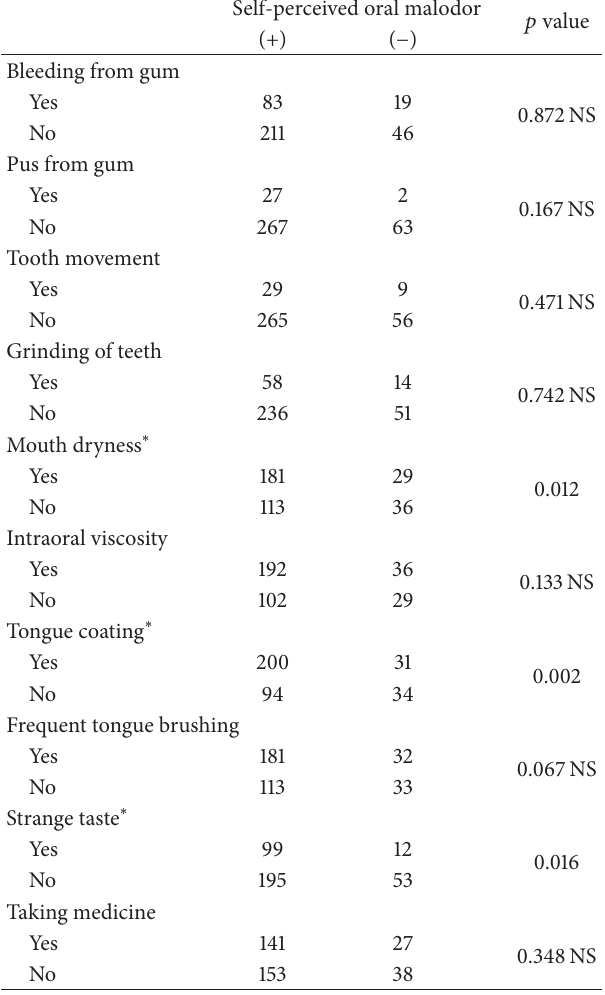
Table 3: Relationships between self-perception of oral malodor and oral complaints.